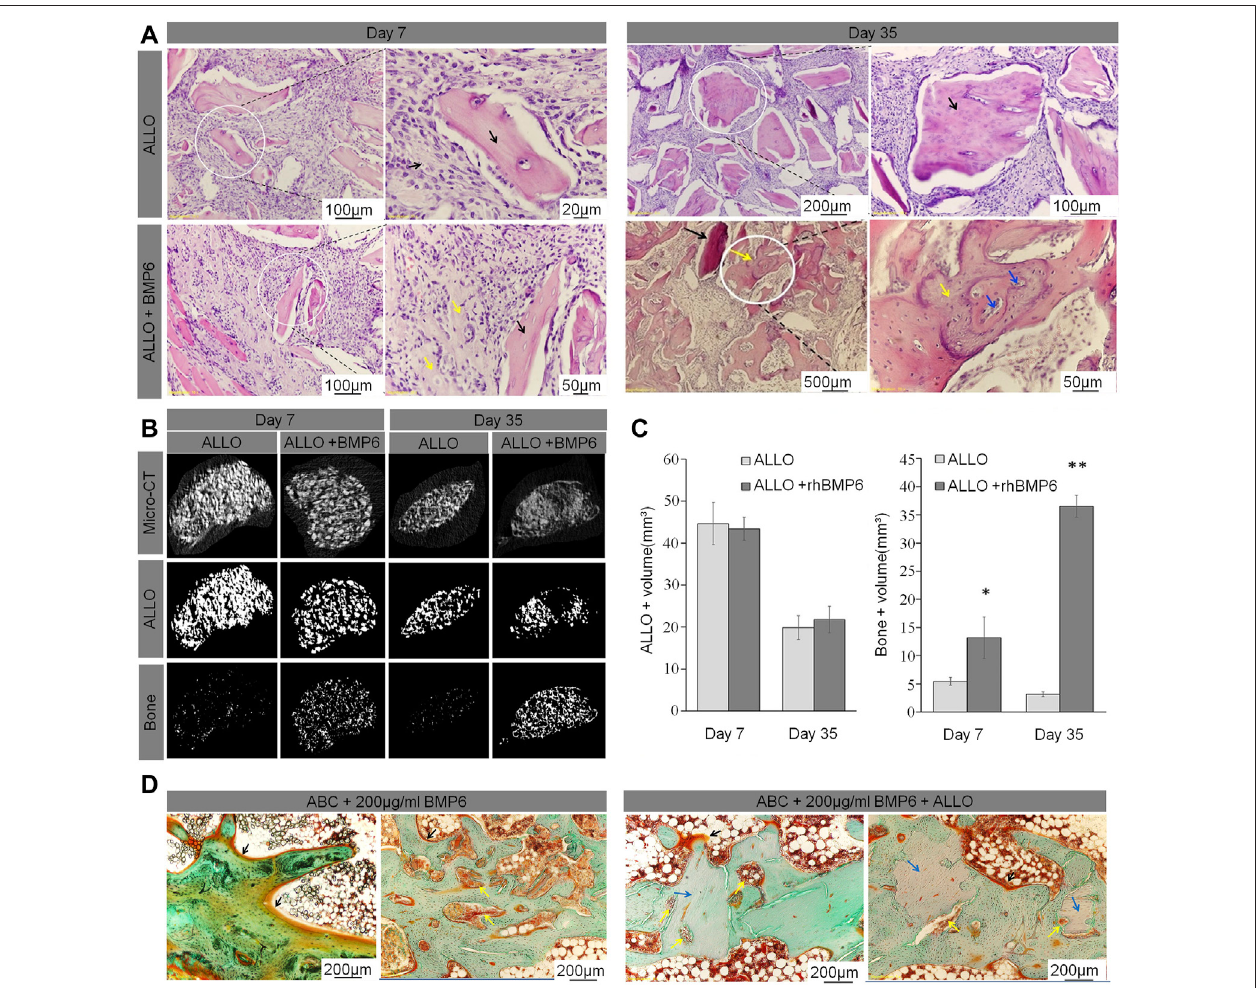
FIGURE 9 | (A) ABC/allograft devitalized bone particles (ALLO) (black arrows) without RhBMP-6 induced formation of fi brotic tissue at days 7 and 35 without any signofnewboneformation.ABC/ALLOwithRhBMP-6hadinducednewboneformationbyday7(yellowarrows),andadvancedcreepingsubstitutionofALLOwithnew bone was observed on day 35 (blue arrowhead). (B) Overall micro-CT analyses of ABC/ALLO implants without and with RhBMP-6 are shown in the top row, only ALLO particles are visualized in the middle row, and the bottom row shows the newly formed bone (images obtained upon subtracting the ALLO particles from overall micro-CT images), respectively. Note the formation of new bone by day 7, with signi fi cant formation by day 35 in ABC/ALLO implants that contained RhBMP-6. ABC/ ALLOalonedidnotinduceboneeitherat7or35daysafterimplantation. (C) MorphometricanalysisofALLOvolumeinimplantsondays7and35,indicatingasigni fi cant decreaseinALLOvolumeandincreasedamountofboneinthepresenceofRhBMP-6. (D) HistologyofABCimplantswithoutandwithALLOharvestedat14 weeksafter surgery in a rabbit model. Note the newly formed bone with a dense trabecular structure with laid-down osteoids at the surface (black arrows), pronounced bone remodeling with numerous blood vessels (yellow arrows), and the newly formed trabeculae assimilated with ALLO (blue arrows) (Grgurevic et al.).